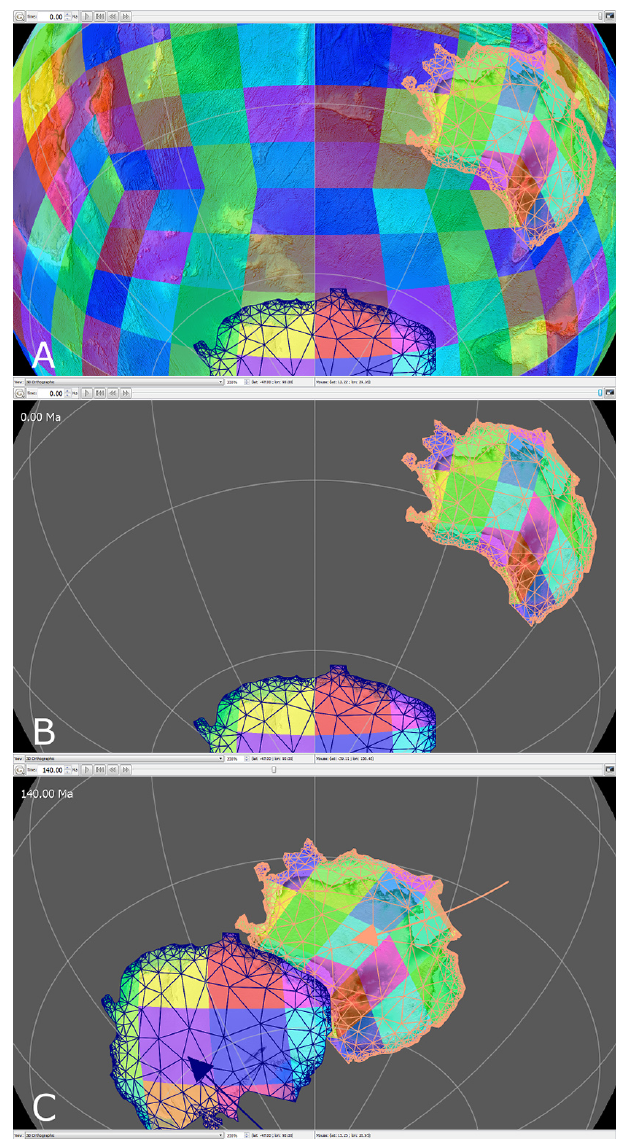
Figure 9. The GPlates “3-D Orthographic” view of the ETOPO1 global raster (Amante and Eakins, 2009) reconstructed to 140Ma using the Australian and Antarctic continents. The cube map tiles are highlighted in different colours. (A) The entire unreconstructed raster with the tectonic polygon meshes overlaid on top. Note the cube-like arrangement of tiles – two cube corners are noticeable in the pattern of tiles. (B) The tectonic polygon meshes in their present-day (0Ma) locations essentially cut out polygon-shaped blocks in the global raster and its tiles. (C) The tectonic polygon meshes in their reconstructed locations at 140Ma. Each plate rota- tion is illustrated by a curved arrow. The raster and its tiles rotate independently with each tectonic polygon